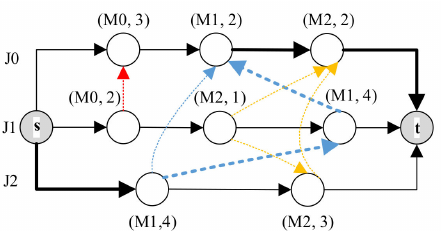
Figure 22. An example for a disjunctive graph representing a job shop system.